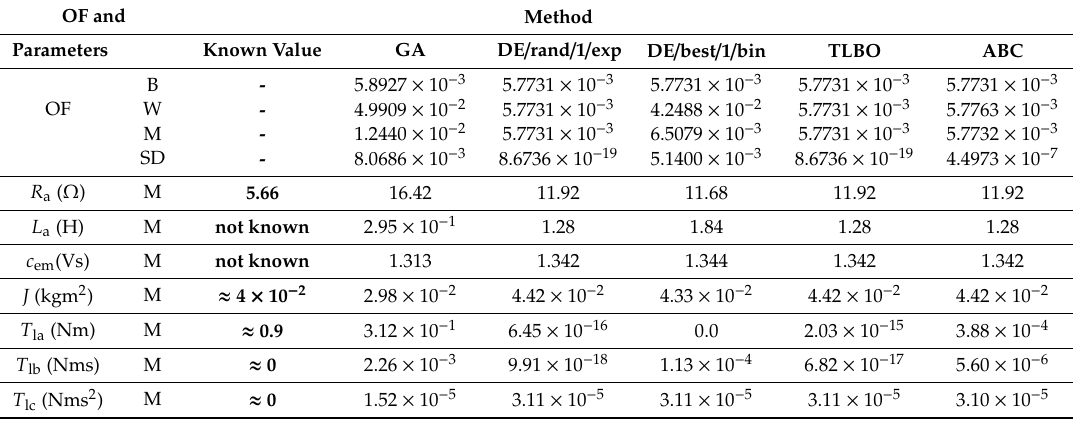
Table 13. OF and Mean value of the calculated parameters for 50 independent runs using EM for MD3.